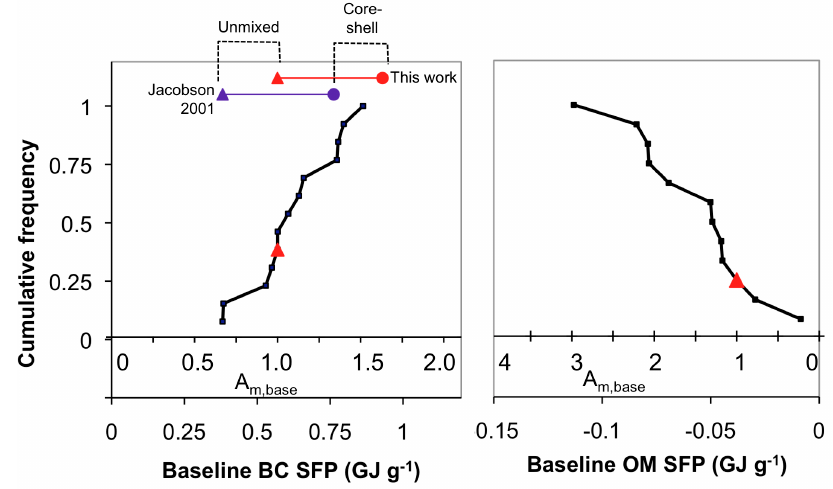
Fig. 7. Comparison of our baseline model results with AeroCom tabulation. Each figure shows SFP dir derived from 12 models in the AeroCom tabulation, which reported normalized direct radiative forcing and aerosol lifetime. Cumulative graphs indicate the fraction of models reporting SFP dir below the indicated value. A m, base is the SFP for each model divided by SFP for the reference model (red triangle). Figure for black carbon (left) also shows the effect of internal mixing from CAM and one other model (top). Ratio between core-shell SFP and unmixed SFP indicates enhancement ( E mix )